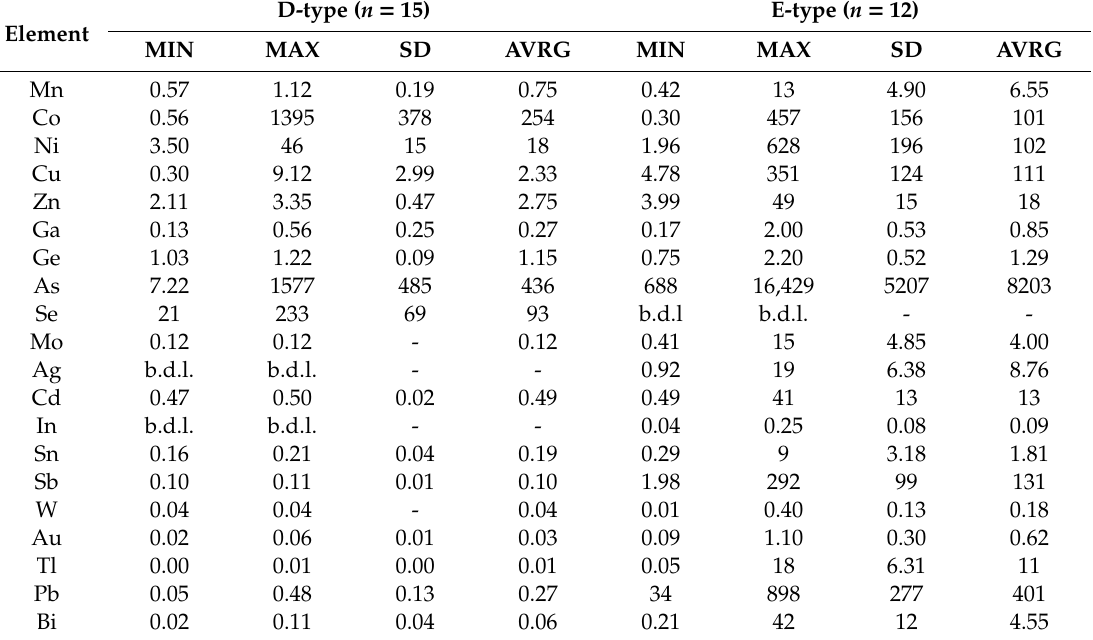
Table 3. LA-ICP-MS analyses of various pyrite generations from the Konos Hill porphyry / epithermal prospect. All values are reported in ppm. For the full dataset please refer to supplementary Table S3.